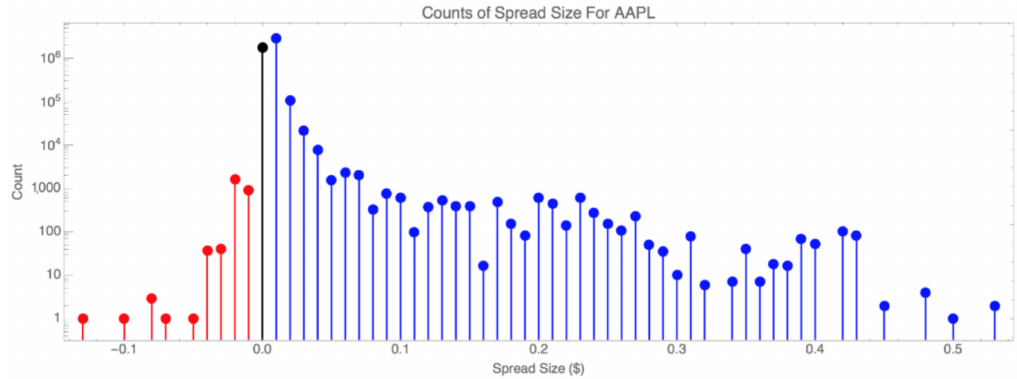
Figure 14. Bid/ask spread in dollars vs. number of occurrences for Apple stock on 11 August 2015.